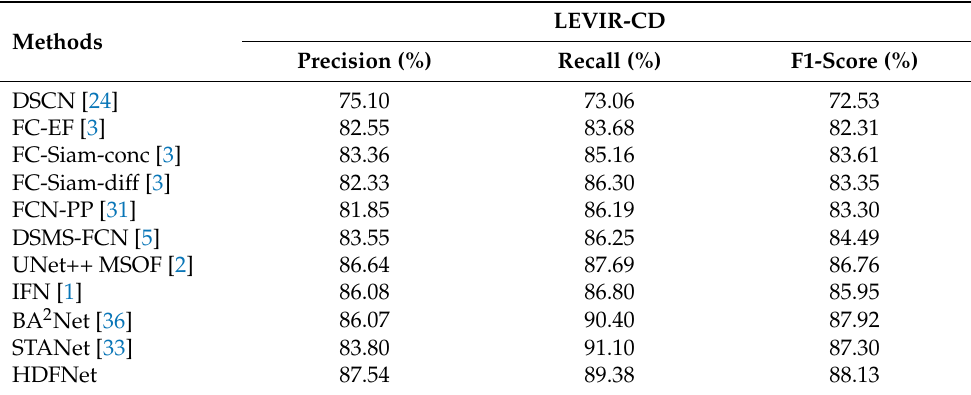
Table 2. Result Comparison on dataset